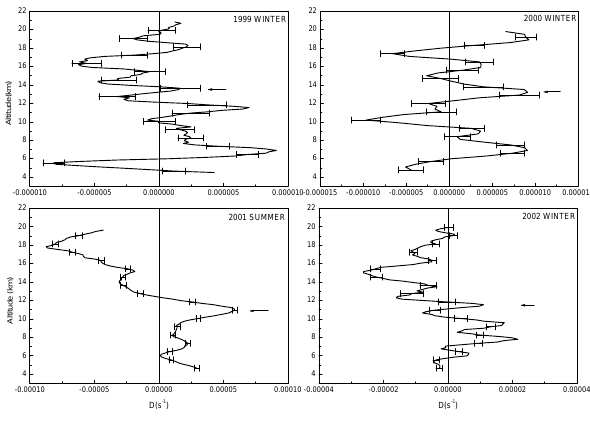
Fig. 2. Seasonal average profiles of D for winter 1999, winter 2000, summer 2001 and winter